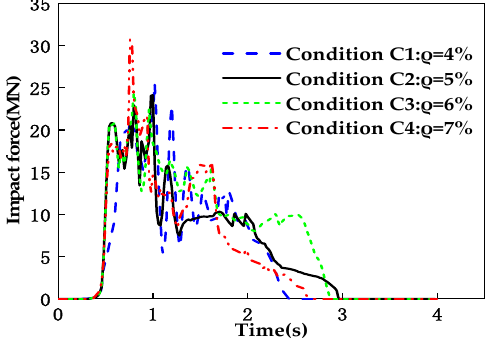
Figure 27. Impact force time-history curves of pier.